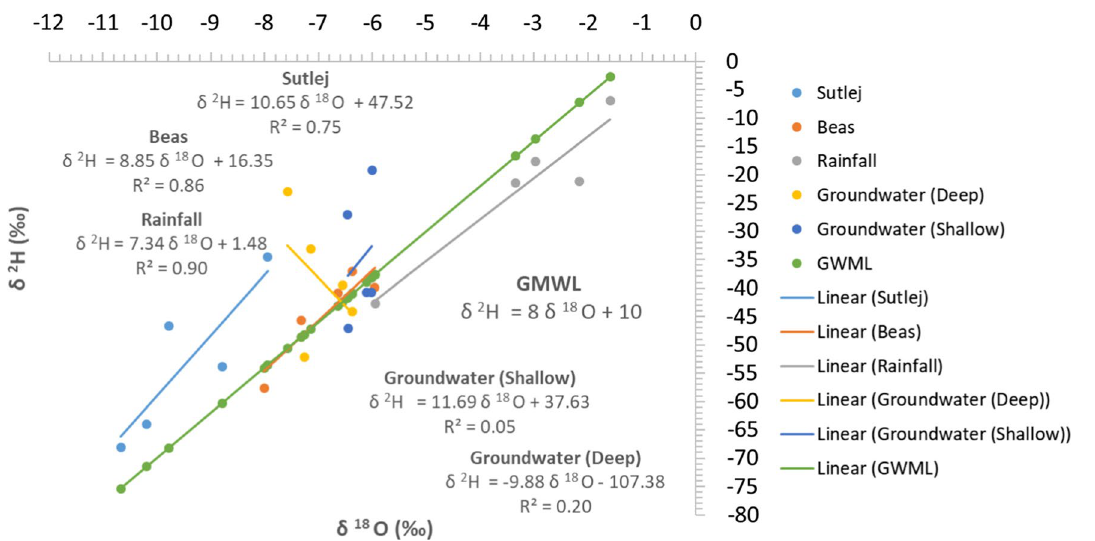
Fig. 9 The isotopic water lines of the river Sutlej, the river Beas, the rainfall, the deep aquifer, and the shallow aquifer compared with the global meteoric water line defined by Craig